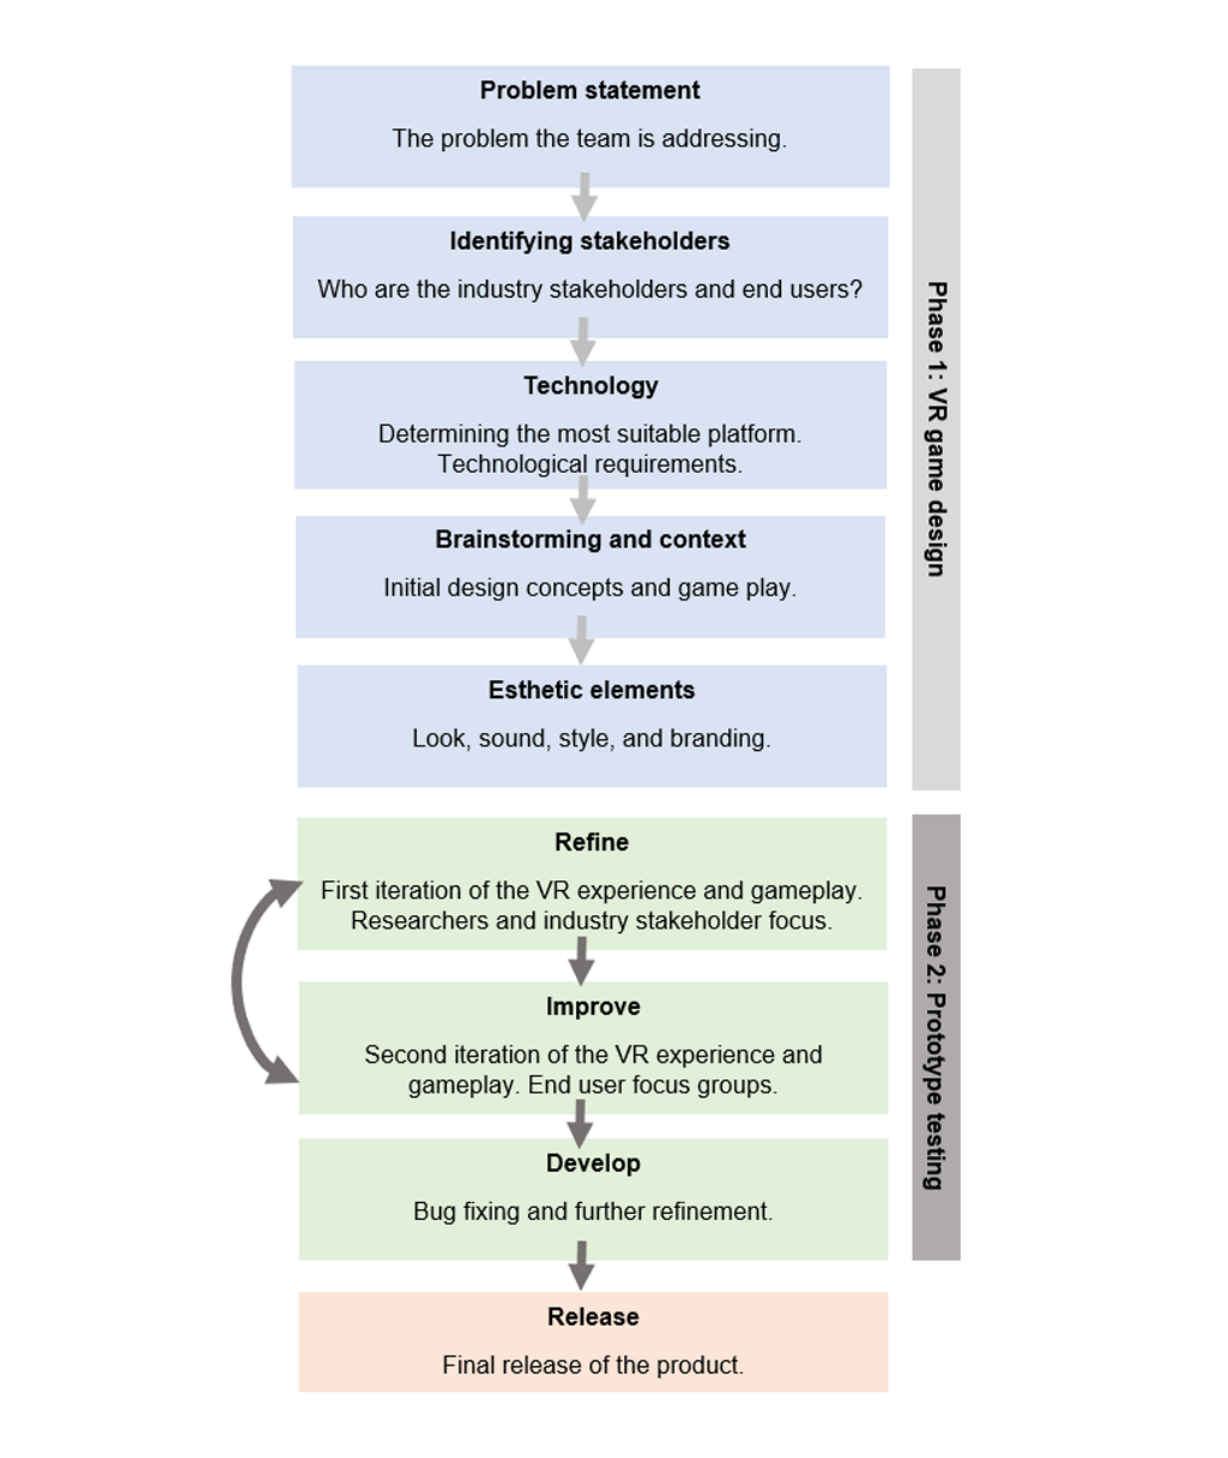
Figure 1. Flow chart of the design and development process. VR: virtual